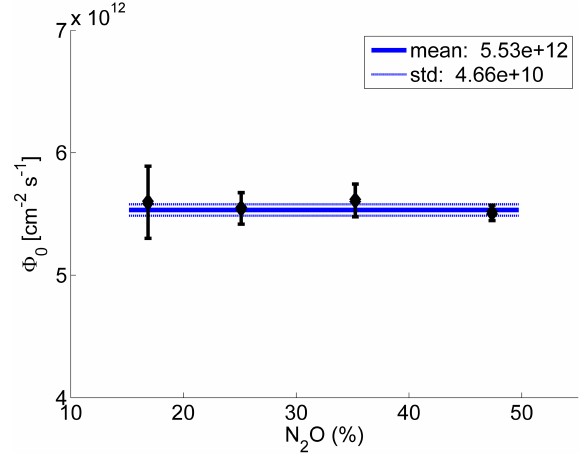
Fig. 5. Photon flux 8 0 calculated from NO measurement for differ- ent N 2 O mixing ratios.